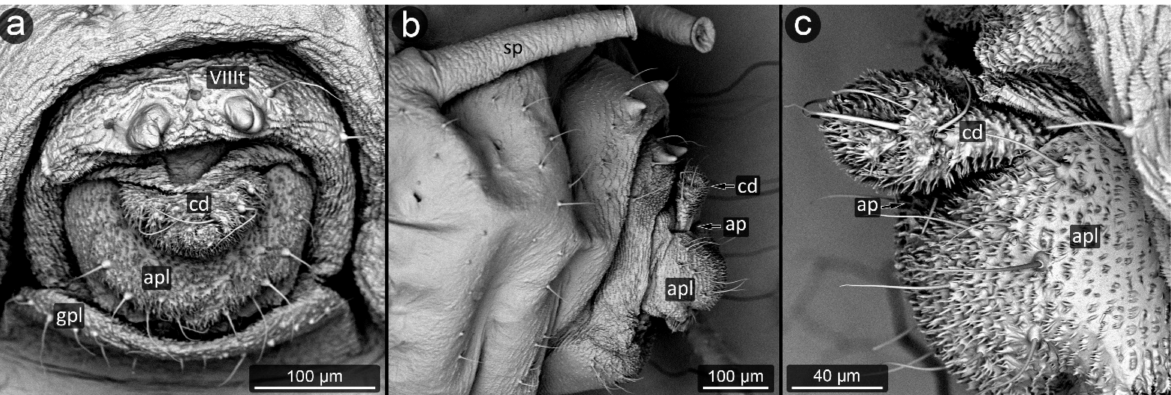
Figure 26. Perianal structure of Dysaphis plantaginea in SEM; ( a )—rear view, ( b )—lateral view, ( c )— close-up on the surface of cauda and anal plate.